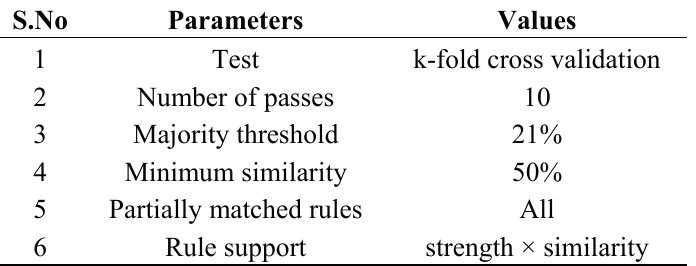
Table 9. Experimental setup used for validation of prediction rules in ROSE 2